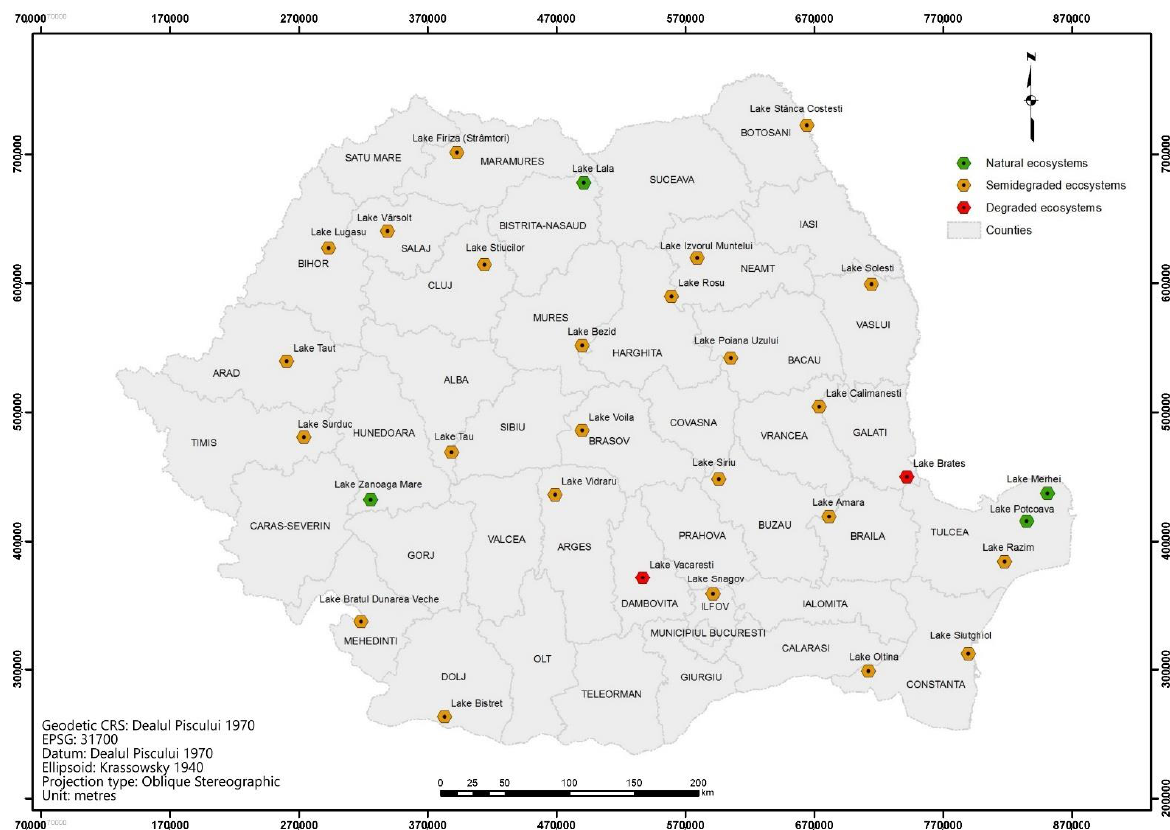
Figure 9. Degradation state of studied lake ecosystems.